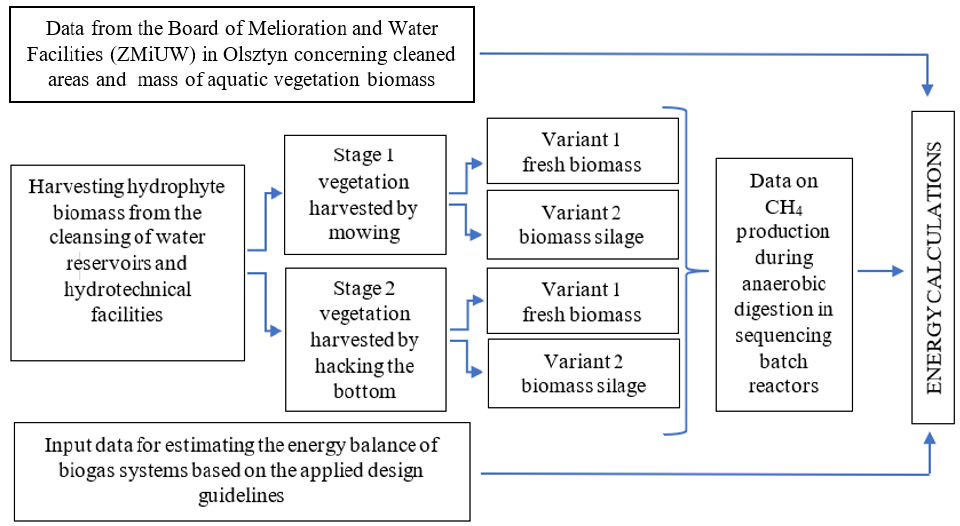
Figure 2. Block diagram of experimental, inventory, and computational works.